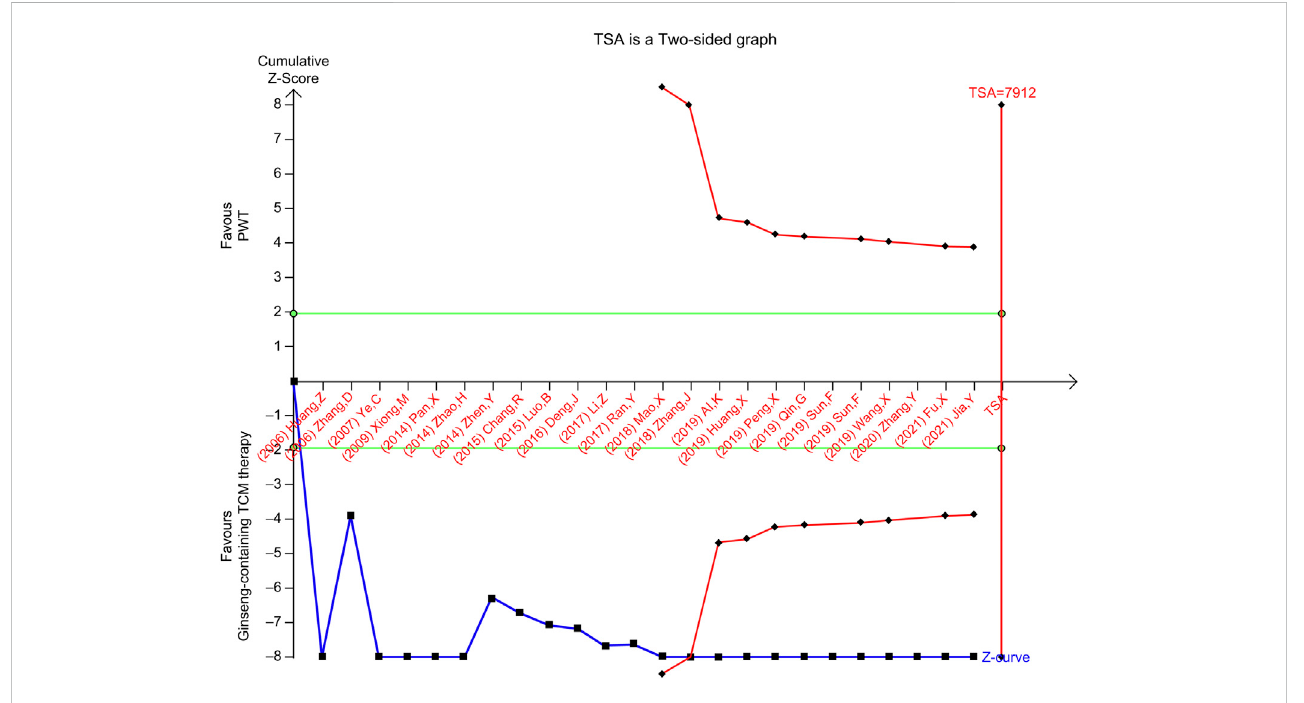
FIGURE 6 TSA of LVEF, left ventricular ejection fraction; TSA, trial sequential analysis.